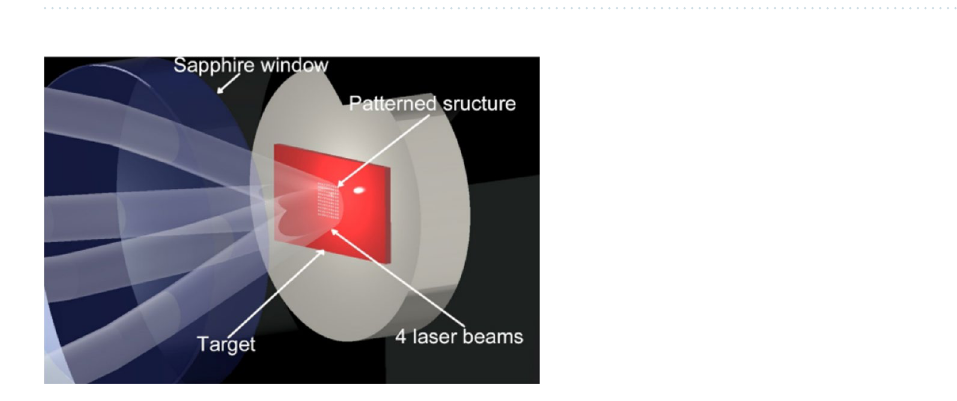
Figure 5. Schematic model for four-beam laser interference patterning in CO 2 at 100 bar